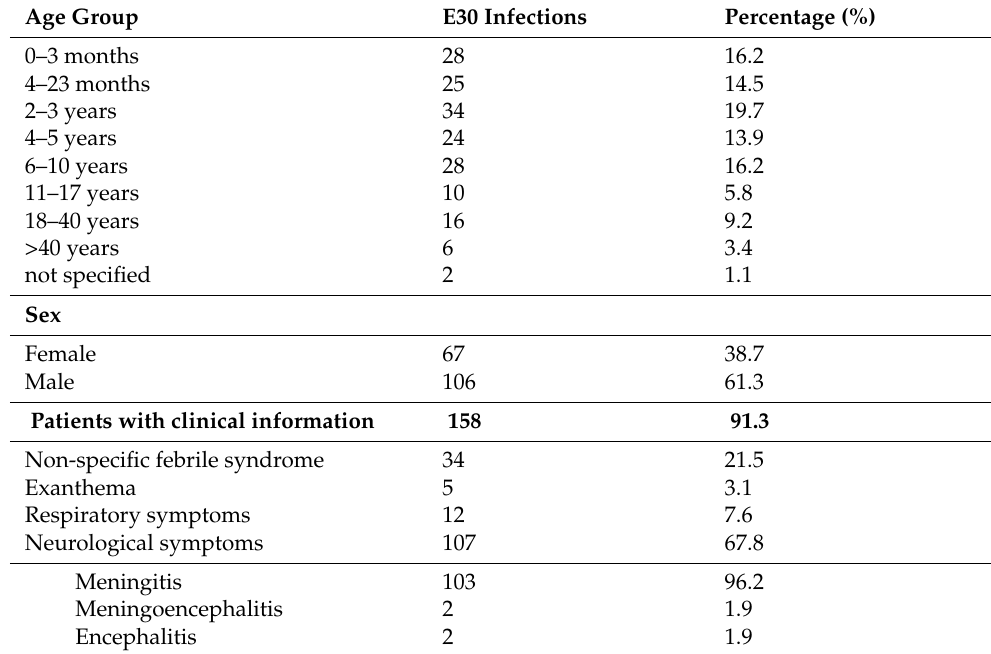
Table 1. Demographic and clinical characteristics of 173 patients with E30 infection.